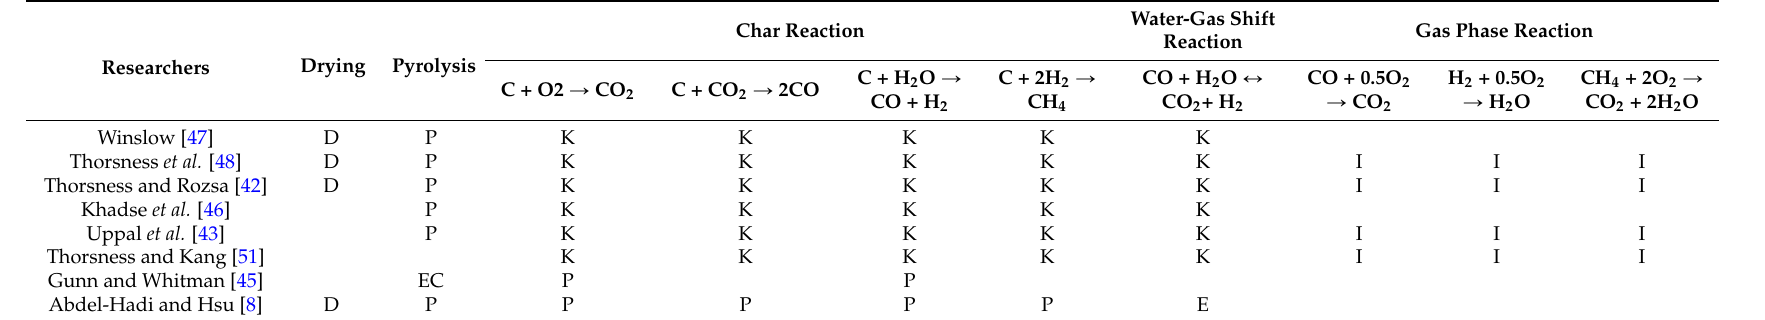
Table 5. Reaction rate control mechanisms of the main reactions in the gasification